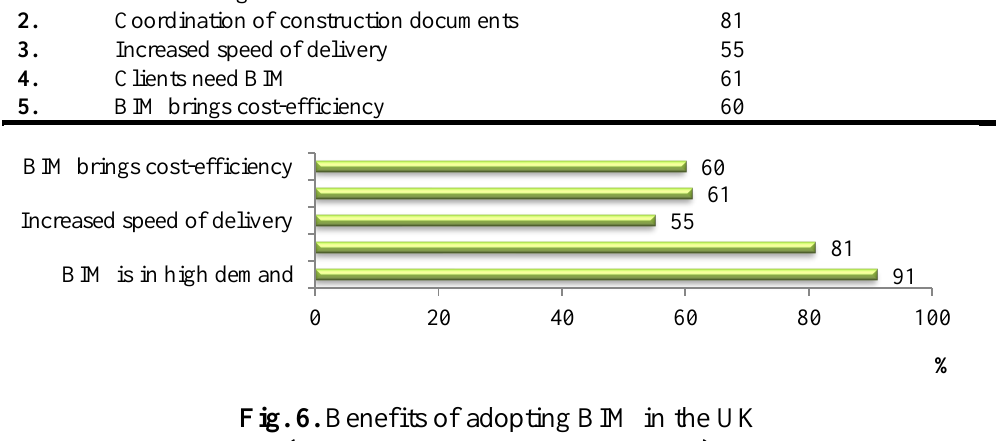
Fig. 6. Benefits of adopting BIM in the UK (National BIM Report, 2019, p.